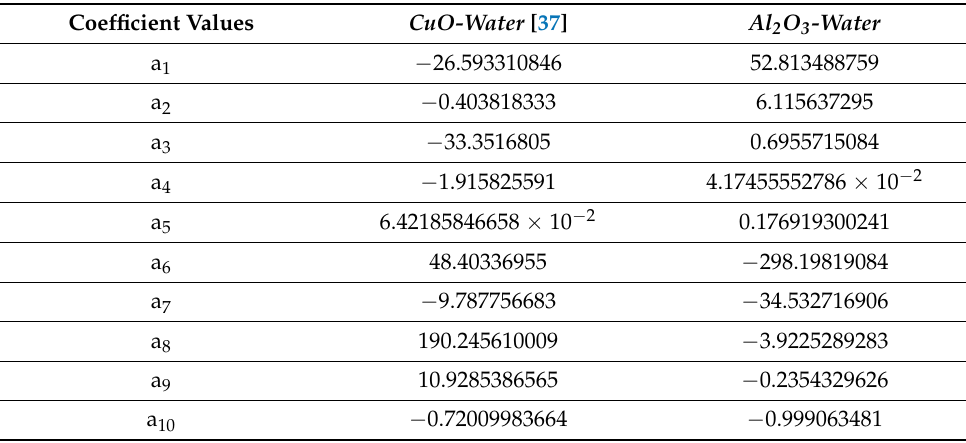
Table 3. The coefficient values of CuO and Al 2 O 3